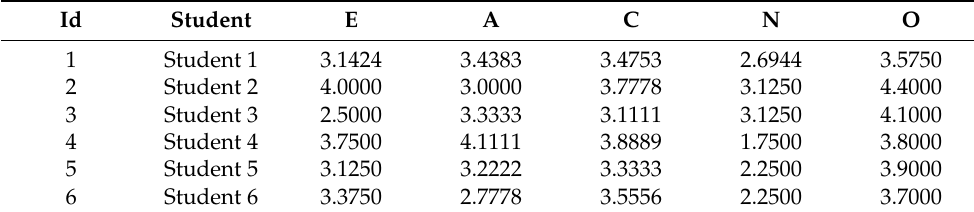
Table 4. Example students.